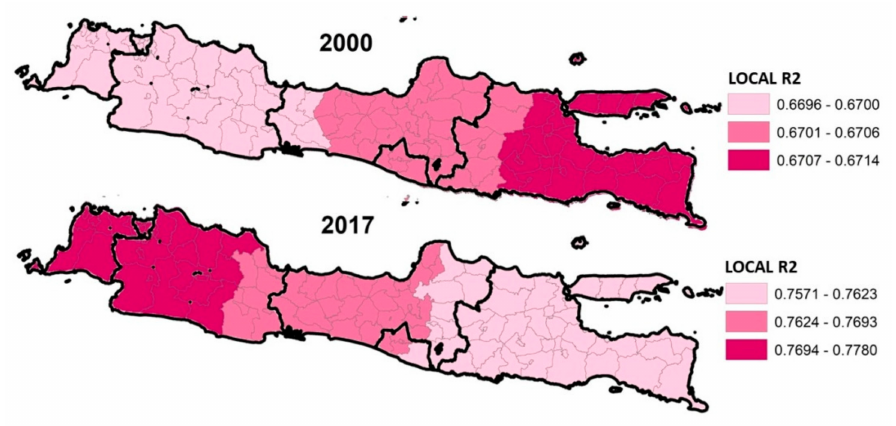
Figure 2. Local R -square of RDI in 2000 and 2017 based on the GWR